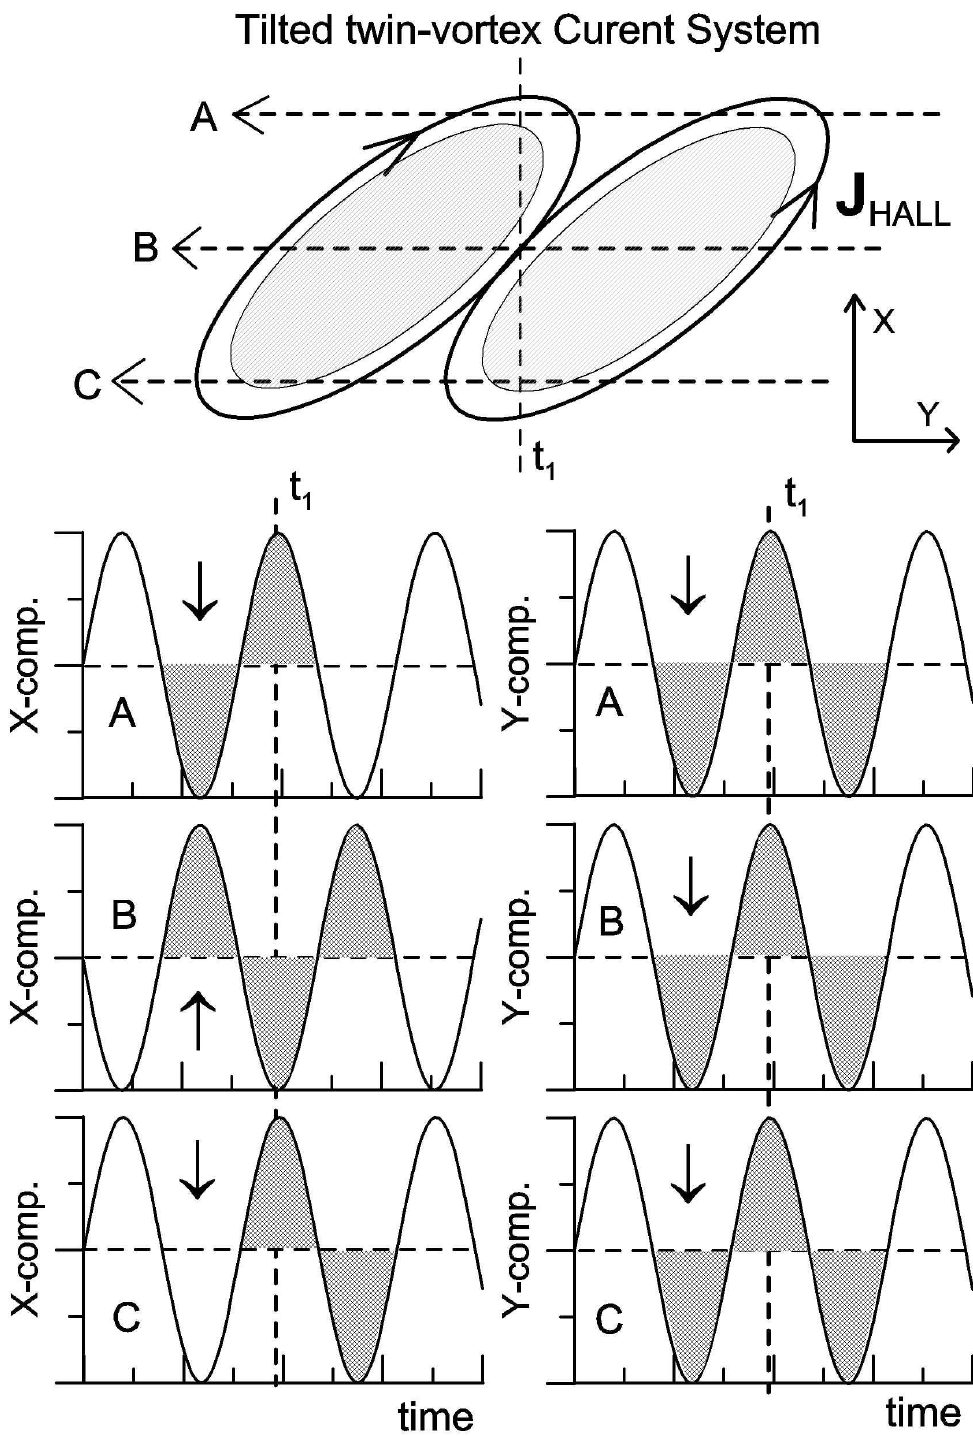
Fig. 15. Tilted twin-vortex current system with opposite polarities of Hall currents, which although naturally moves antisunward above the IMAGE stations, here is considered stationary. Current flow is denoted with an arrow on each vortex structure, while the Sun is located to the left side of this page. The representative ground stations A, B and C are considered to move sunward below the Hall currents. The ground responses, along the three tracks (horizontal-dashed lines) for the three stations, are drawn underneath the vortices. For each track the X and Y magnetometer components are sketched, while it is apparent that at the moment t 1 (vertical-dashed lines) a double phase change of 180 ◦ takes place within the latitude range extended from A to